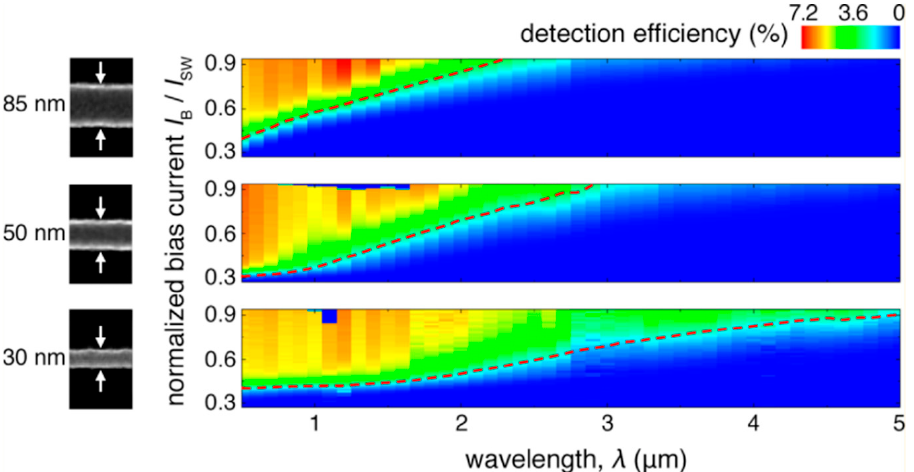
Figure 3. Detection efficiency (in color scale) vs. λ and normalized bias current (I B /I SW ) for SNSPDs based on 85 nm wide, 50 nm wide, and 30 nm wide nanowires. Each pixel of the color map corresponds to an experimental data point. The red dashed lines are the Ico vs. λ curves of the three detectors. The blue pixels for high bias current and λ < 2 µm are due to the detectors switching to the normal state. Reprinted with permission from [49], copyright 2012.